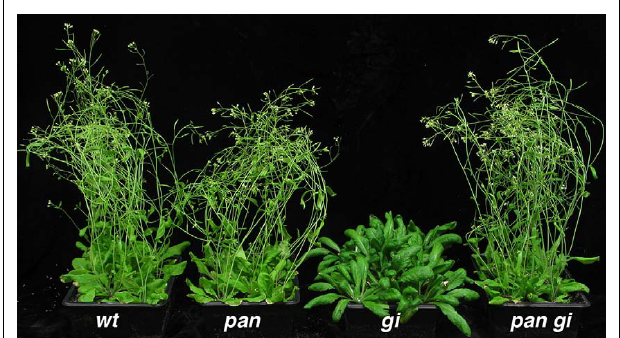
FIGURE 5 | Genetic interaction of PAN with GI . Plants grown for 25day under LD are shown. mRNAs we found diverse functional sub-categories indicating that PAN plays a role in stress and environmental response ( Figure 4